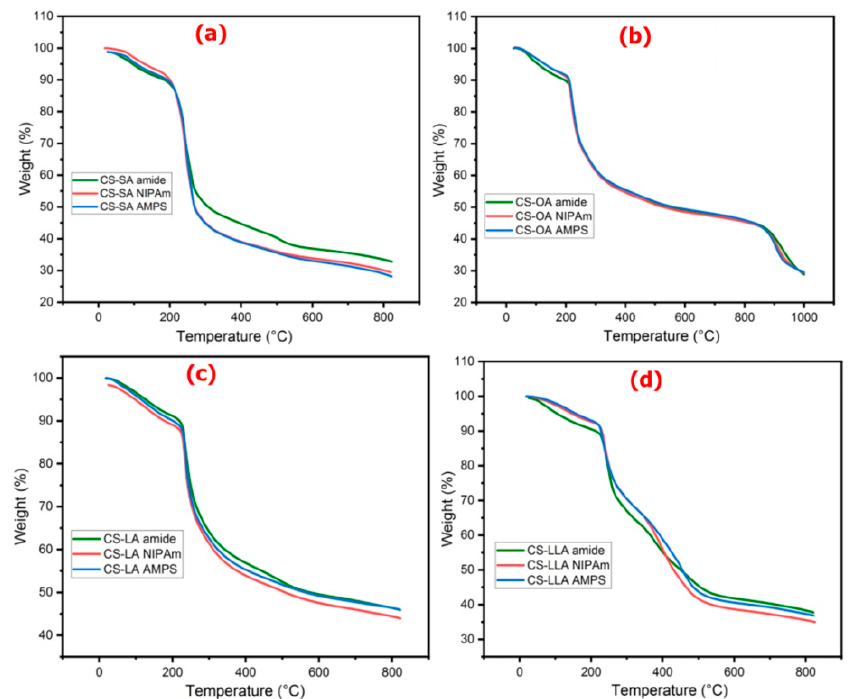
Figure 3. TGA comparison of CS-amides-modified NIPAm and AMPS; ( a ) SA; ( b ) OA; ( c ) LA; and ( d ) LLA.